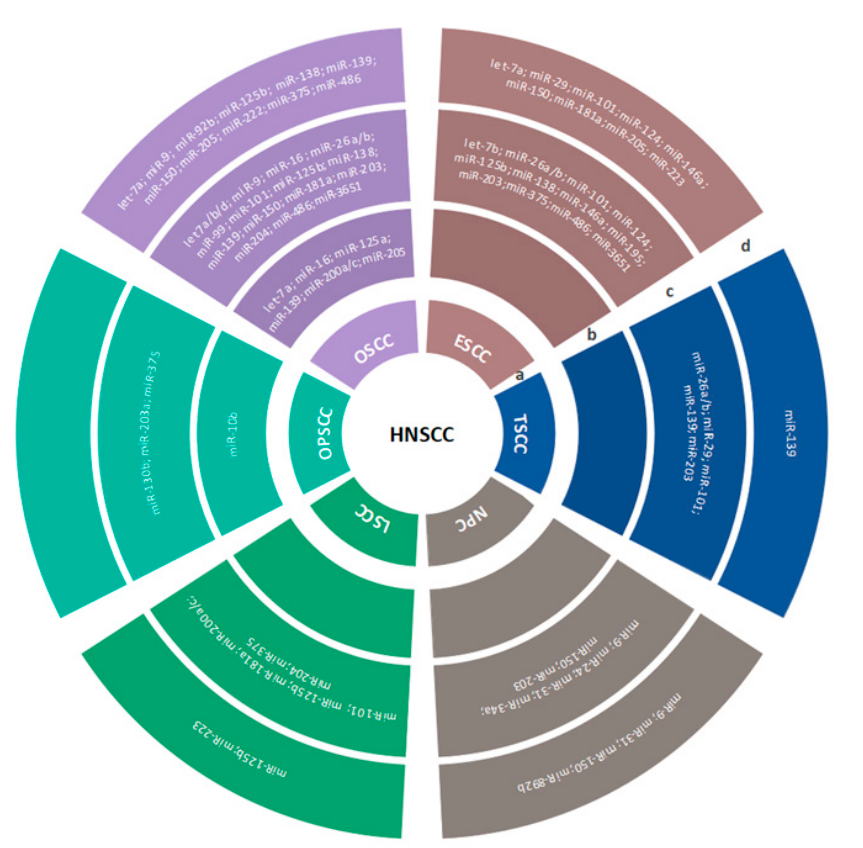
Figure 2. Overview of the most significant miRNAs that are downregulated in HNSCC. The first inner ring represents the subtypes of HNSCC ( a ); the second, third, and fourth rings represent miRNAs detected in saliva ( b ); tumor tissues ( c ); serum, plasma, or peripheral blood ( d ) of HNSCC patients. Table 3. Identified gene hotspots and/or respective pathways and cellular function targeted by Table 2. Summary of the most common downregulated miRNAs reported as potential biomarkers in HNSCC. miRNAs in